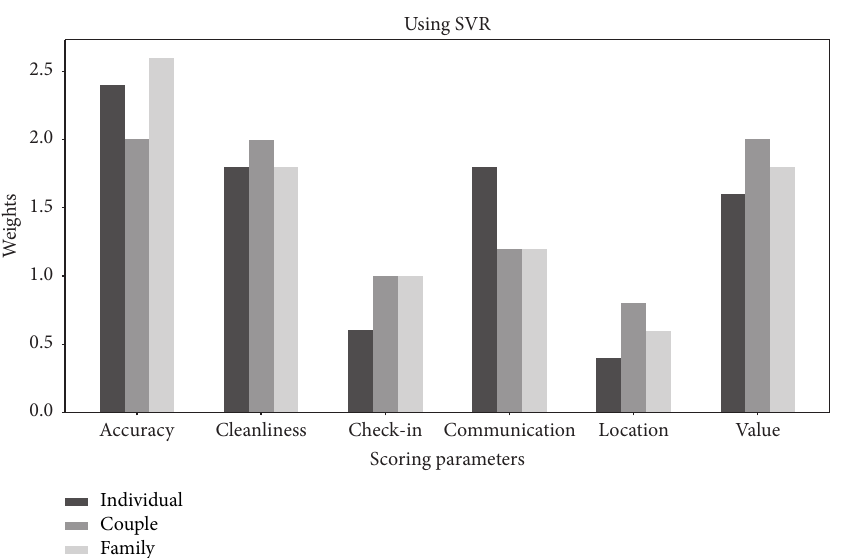
Figure 6: Distribution of coefficients calculated using the SVR algorithm.